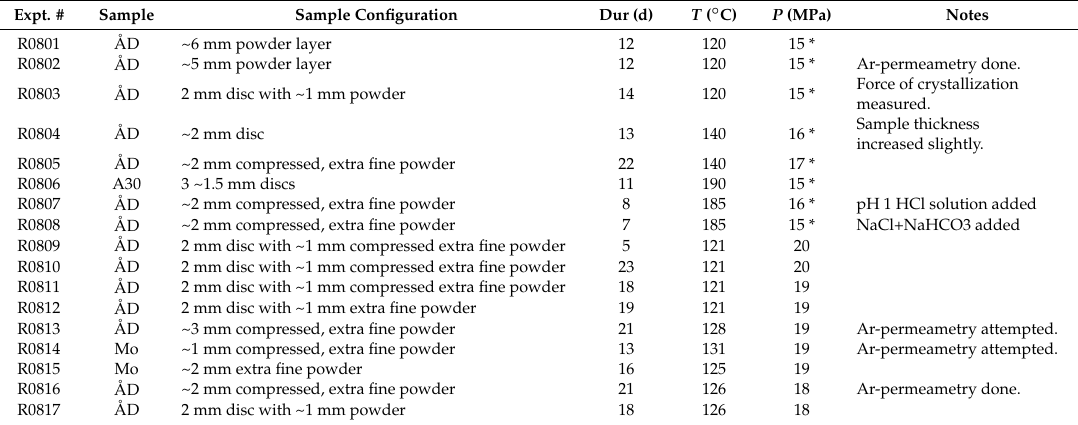
Table 7. A list of all force of crystallization experiments performed, including experimental conditions. Pressures indicated with an asterisk are approximate, unbuffered values. Samples used are Åheim Dunite (ÅD), Oman Peridotite (A30) and Monticellite (Mo). The extra fine Åheim Dunite powder had a grain size of <30 µ